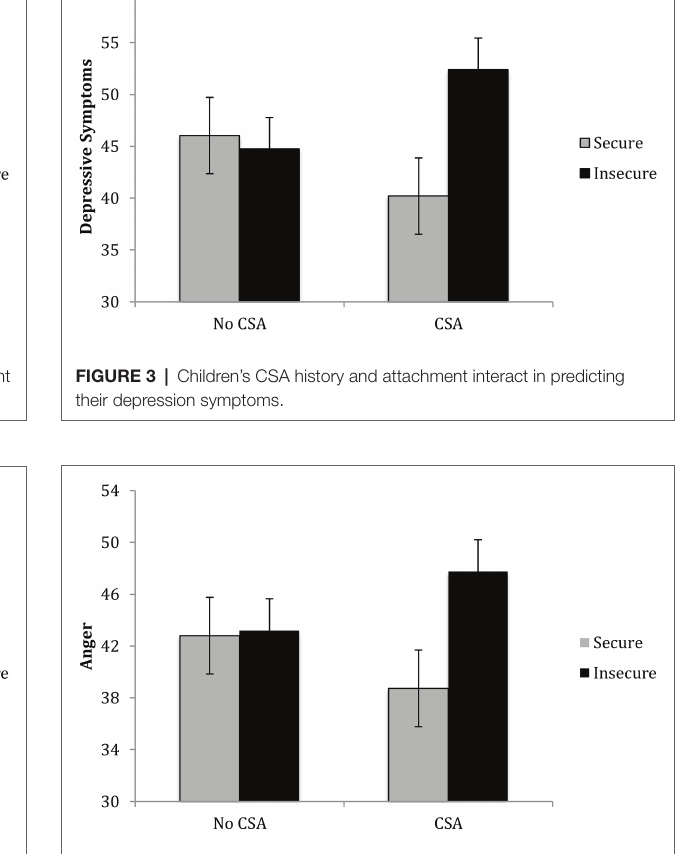
FIGURE 4 | Children’s CSA history and attachment interact in predicting their anger symptoms.